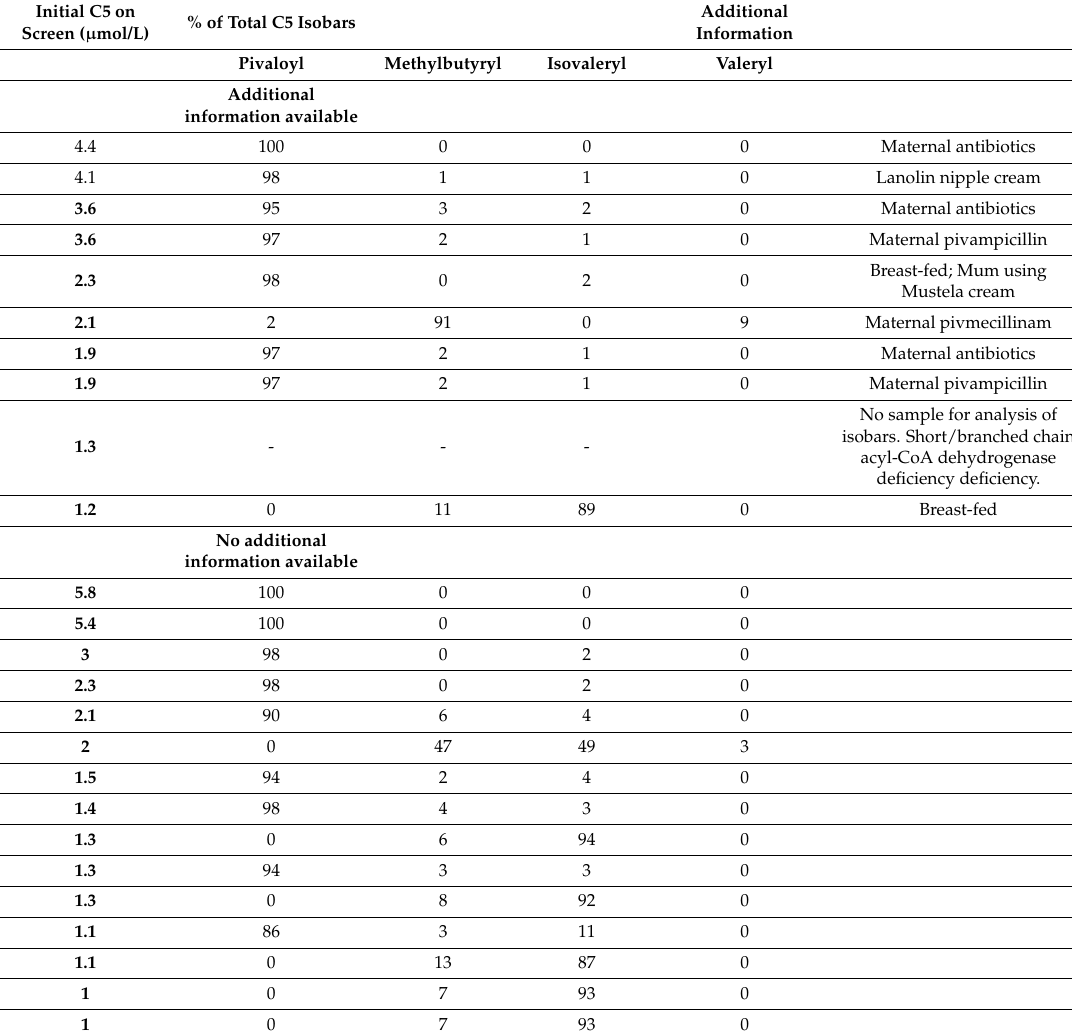
Table 2. Clinically confirmed false positive screening results for isovaleric acidemia from English newborn screening blood spot programme